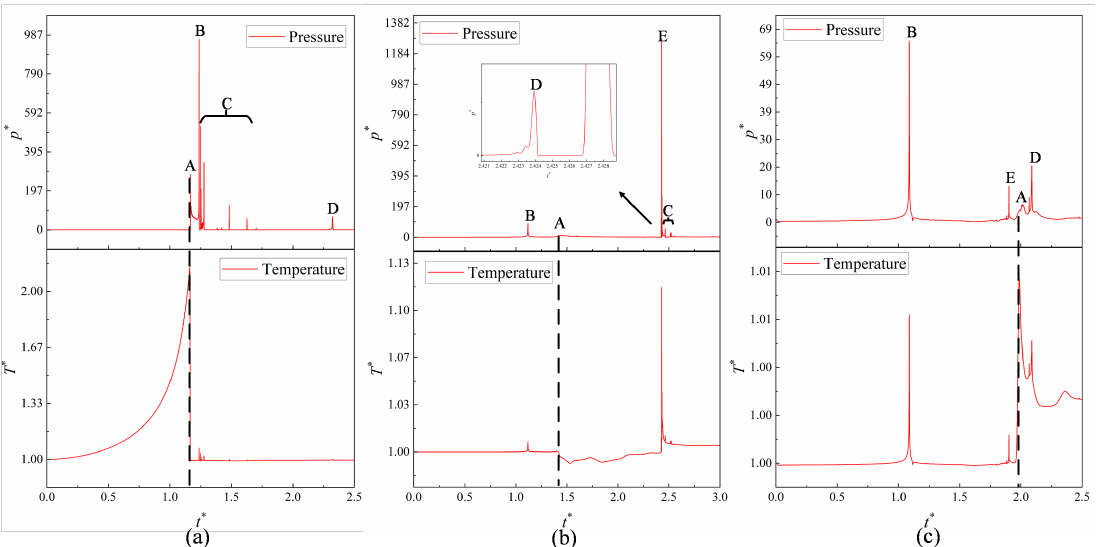
Figure 5. Temporal evolution of the pressure and fluid temperature at the wall center at ( a ) γ = 0.8, ( b ) γ = 1.7, and ( c ) γ = 2.5. The black dotted line represents the moment when the liquid-jet reaches the wall. Multiple pressure peaks, denoted as A to E, are evident. A is formed by the jet impacting the wall because of the splash phenomenon, and the pressure affects this system for a longer duration than the temperature. B is caused by the shock wave created by the first collapse of the cavitation process. The collapses of a series of tiny bubbles lead to C. D can be attributed to the shock wave generated by the second collapse of the bubble. E is caused by the shock wave from the collapse of the split bubble.